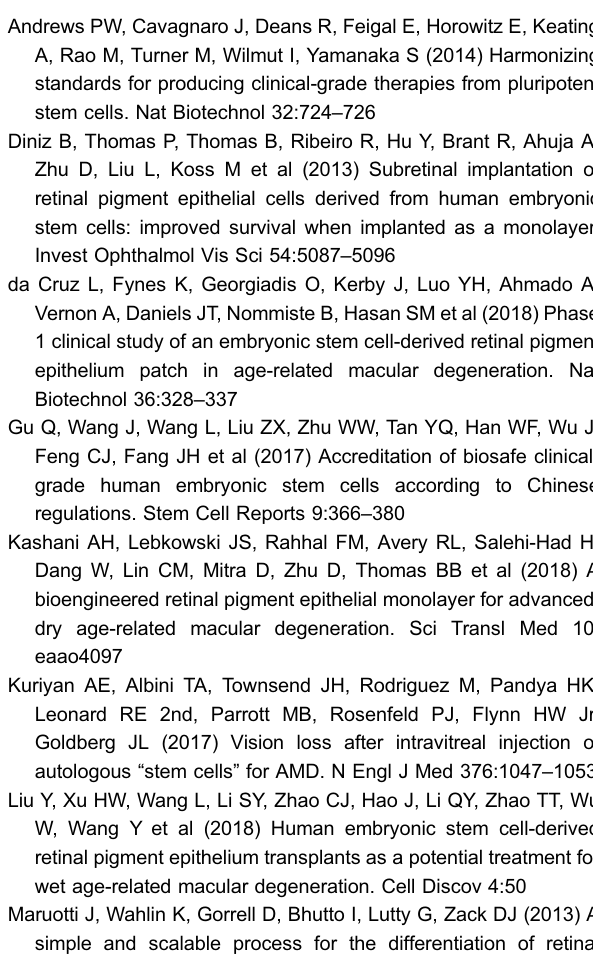
b Figure 2. Comparison of the Q-CTS-hESC-2-RPE cells on a culture plate and PET membrane in vitro and in vivo . (A – C) Immunostaining of the typical RPE markers of PAX6 (A), ZO- 1 (B) and BEST1 (C) in Q-CTS-hESC-2-RPE cells on culture plate. Nuclei were counterstained with Hoechst 33342 (blue). Scale bars = 25 μ m. (D) Orthogonal views of fl uorescence images showed the location of internalized POS in Q-CTS- hESC-2-RPE cells on culture plate. RHODOPSIN (red) was used to show the POS, while F-ACTIN (green) was used to show the cell morphology. Nuclei were stained with DAPI (blue). Arrows indicated the POS. Scale bars = 25 μ m. (A ’ – D ’ ) Same as (A – D), but for the Q-CTS-hESC-2-RPE cells on PET membrane. (E) The representative ERG traces in the control, PET, PET/RPE and RPE suspension groups at 4 weeks after transplantation. (F) Data statistics of amplitude of ERG B wave in the control ( n = 11), PET ( n = 11), PET/RPE ( n = 14) and RPE suspension ( n = 11) groups at 4 weeks after transplantation. (G – H) Same as (E – G), but for 8 weeks after